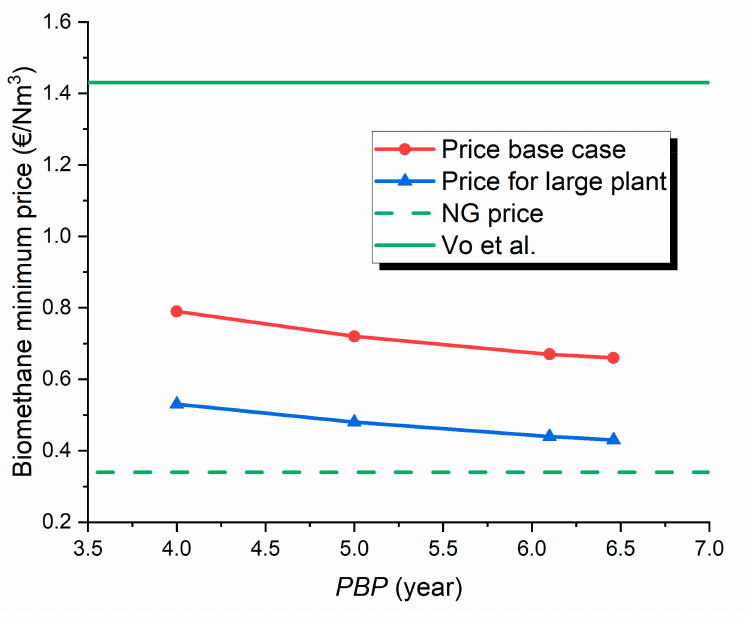
Figure 6. Biomethane minimum price comparison for all of the